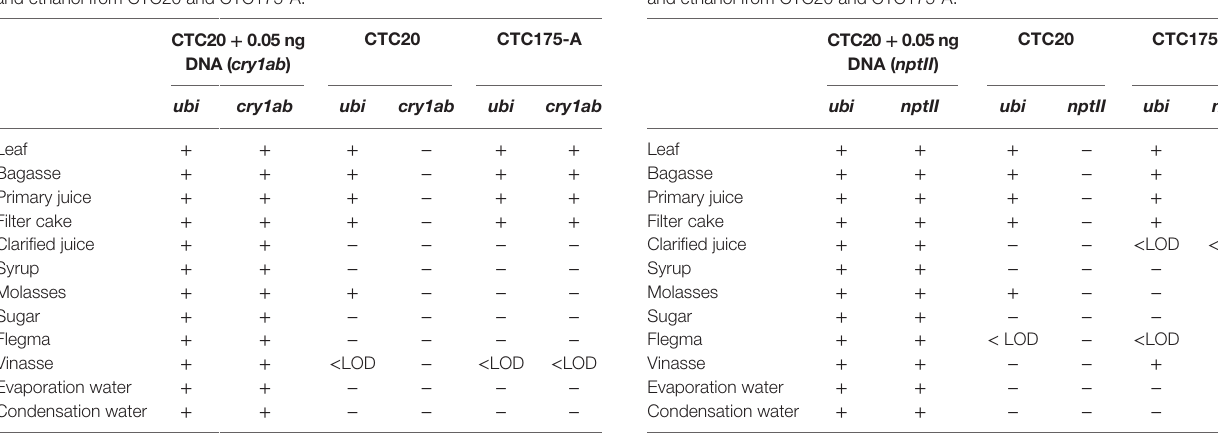
TaBle 9 | Results of gene amplification of ubi (endogenous gene) and nptII in samples collected during the sugarcane laboratory processing to produce sugar and ethanol from CTC20 and CTC175-A.